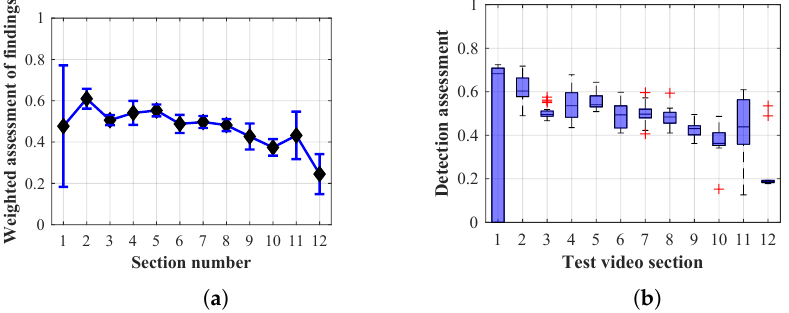
Figure 35. ResultsofMethod1.3withalifespanof40frames. ( a )theweightedaverageratingwiththeaverage mean absolute error of the weighted rating and ( b ) boxplots of the distribution of the statistical sets of the results of the individual sections evaluated indicating: minimum, 1st quartile, median, 3rd quartile,